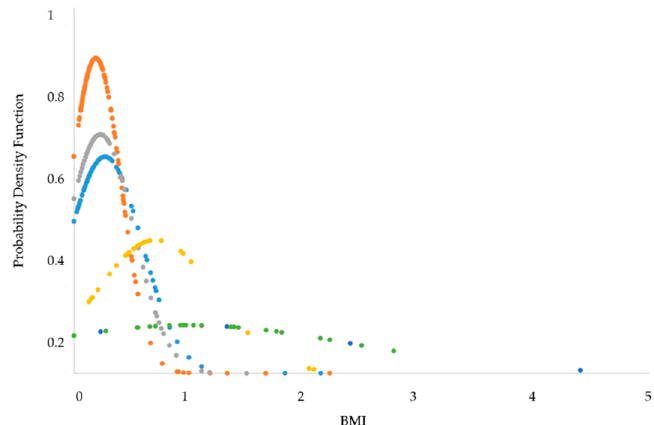
Figure 5. Body movement index (BMI) data distribution. In orange, class LIGHT; in grey, class REM; in dark blue, class DEEP; the class AWAKE: in yellow, Sleep Latency (SL); in green, Sleep Interruptions (INT); in light blue, Time to Wake (TTW).